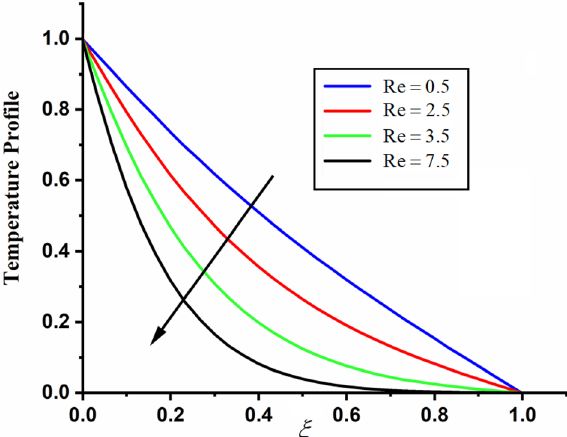
Figure 15. The impact of Re on the temperature of couple stress fluid when α = 0.3 , β = 0.3 , t = 0.2 and Pr = 2 .